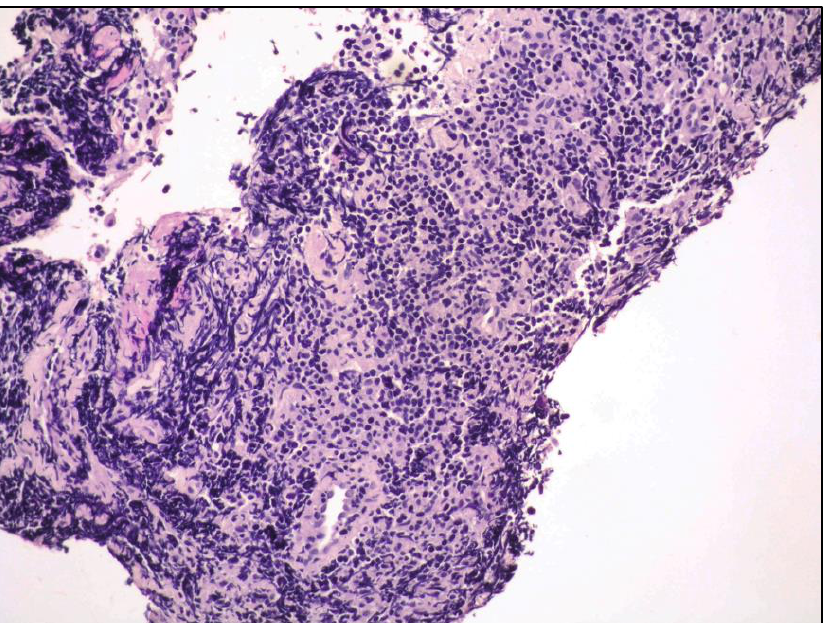
Figure 2. Medium power view showing a lymphoid proliferation composed of monotonous, small lymphocytes (hematoxylin and eosin; 100× magnification; original image from Prof. S.A.). The neoplastic lymphoid cells were positive for CD20, BCL2, SOX11 and cyclin D1 and negative for CD5, CD23, CD10, BCL6, IRTA1, CD138, MUM18 and CD3 (Figures 3–5).